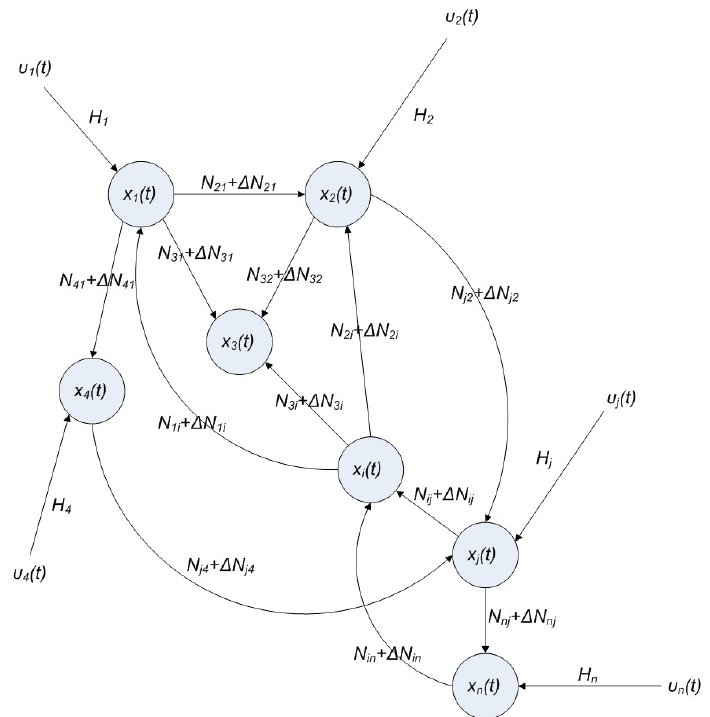
Figure 7. The linear n genes GRN with interaction N expression x ( t ), and extrinsic fluctuation υ i